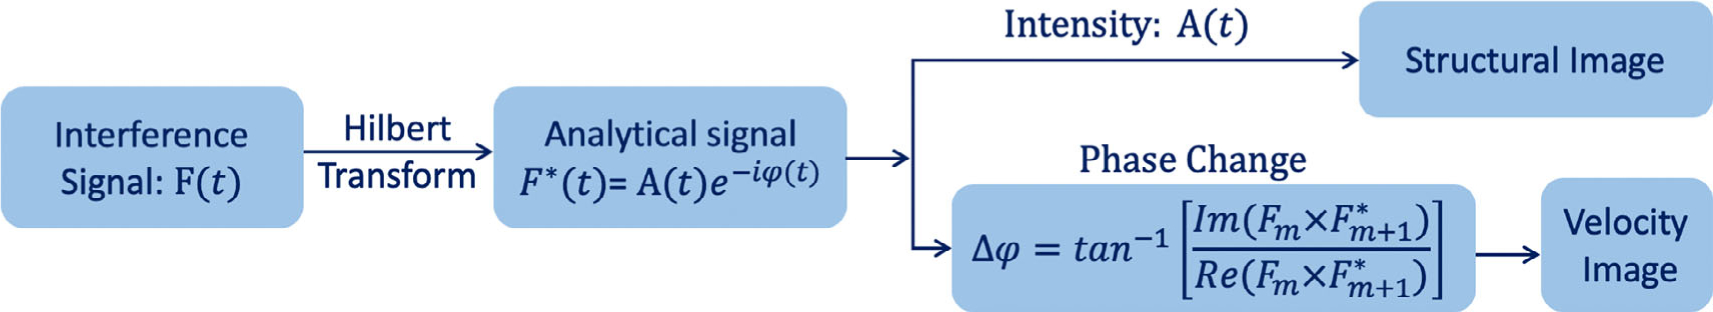
Phase-resolved Doppler optical coherence tomography method